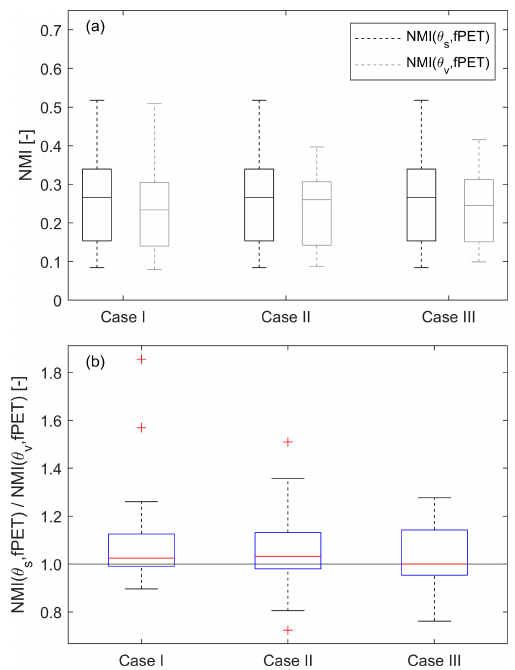
Figure 2. The θ / ET coupling strengths for summertime anomaly time series from AmeriFlux measurements using three different θ v calculation methods: (a) NMI( θ s , fPET) and NMI( θ v , fPET) indi- vidually and (b) NMI( θ s , fPET) divided by NMI( θ v , fPET) for mul- tiple θ v cases. Case I is based on the application of an exponen- tial filter to extrapolate 0–10cm θ s to a consistent 0–40cm bottom- layer depth, while Cases II and III refer to the direct use of only the bottom-layer measurement and a linear interpolation of both the top and bottom layer, respectively, to calculate θ v (see Sect. 2.1 for details on each